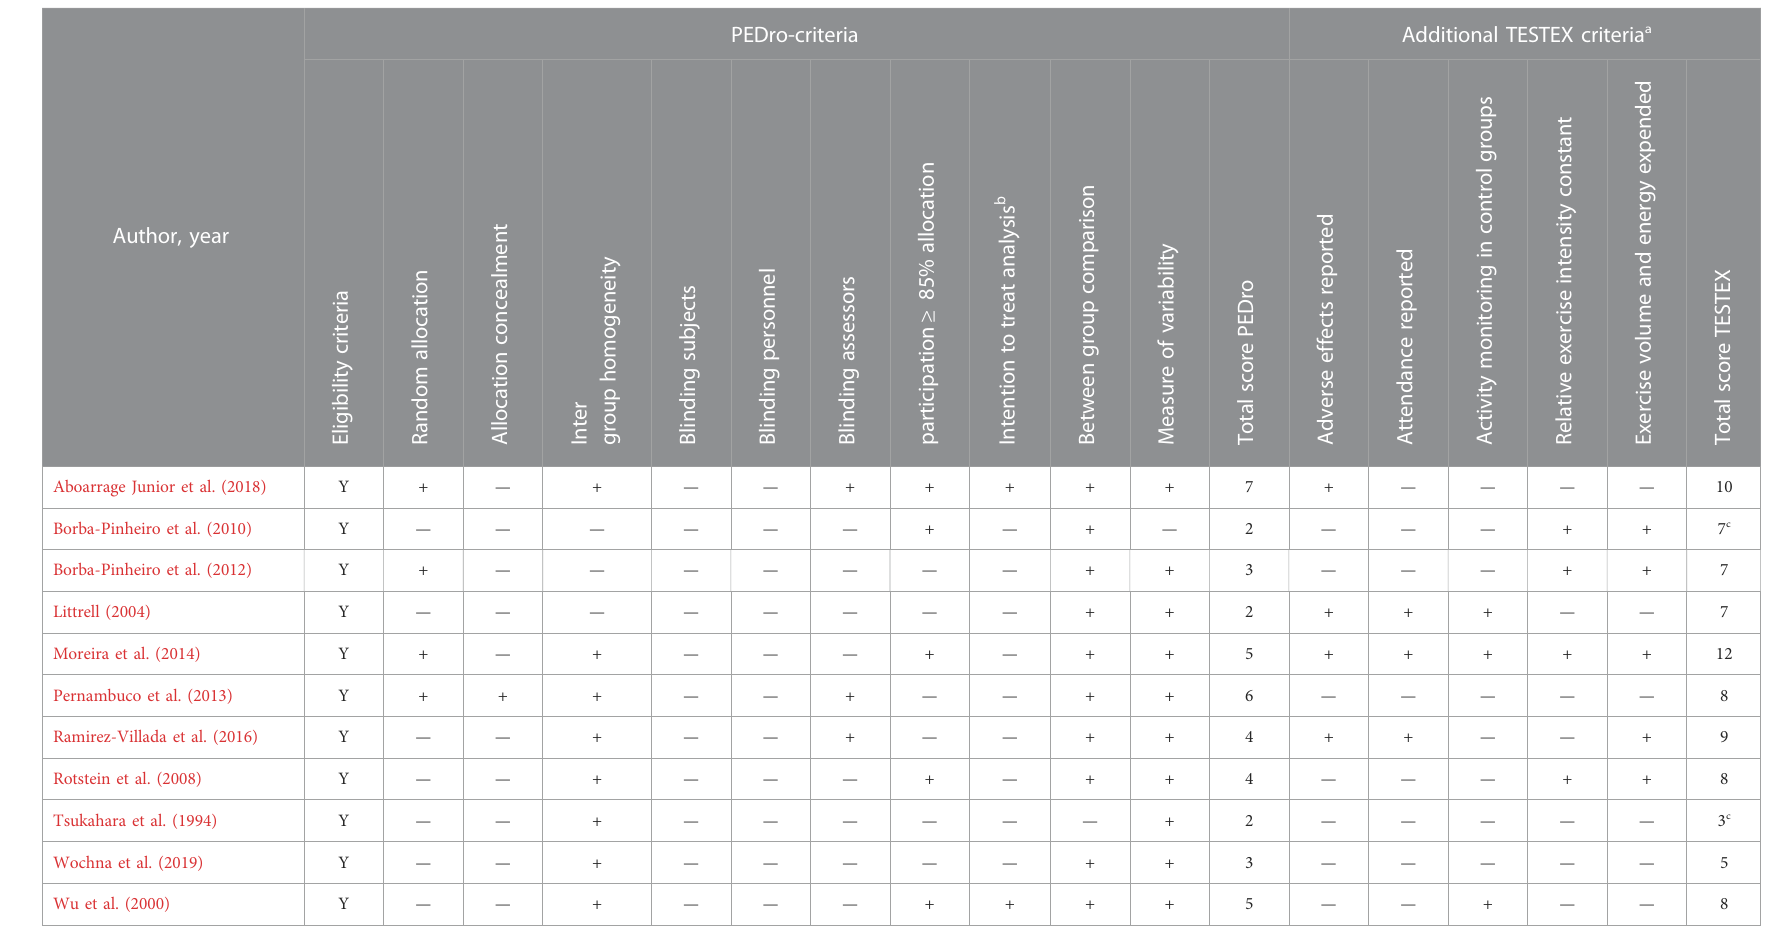
TABLE 3 Methodologic quality of the included studies.